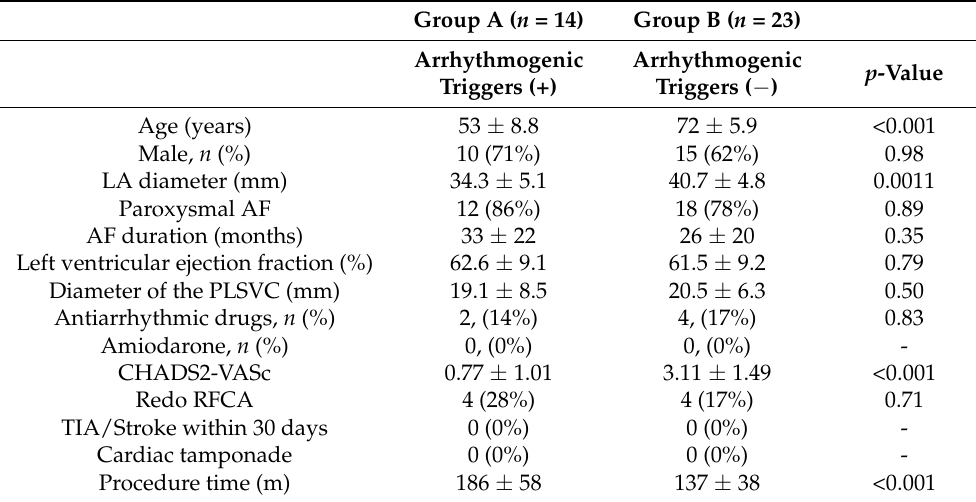
Table 2. Provocation of Arrhythmogenic Triggers from